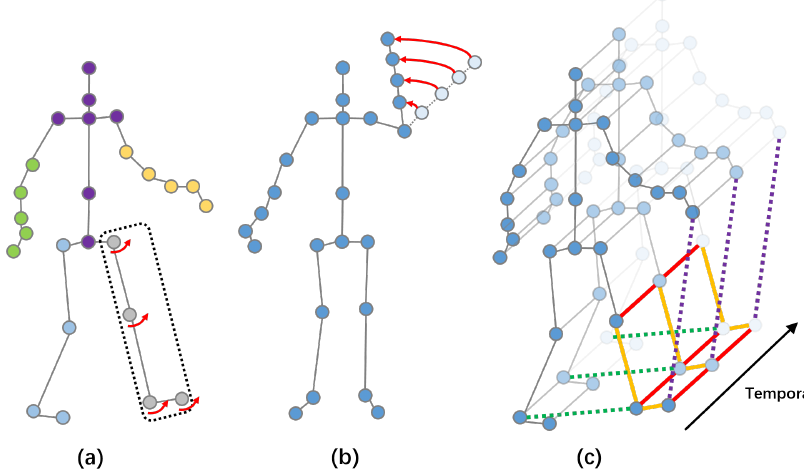
Figure 1. ( a ) An example of similar movement trends of the same part. ( b ) An example of joints near the edge moving more significantly than joints near the center. ( c ) The spatial temporal graph of a skeleton sequence, in which the red lines connect two joints with temporal correlation, orange lines connect two joints with spatial correlation, green lines connect two joints with symmetric correlation, and purple lines connect two joints with edge